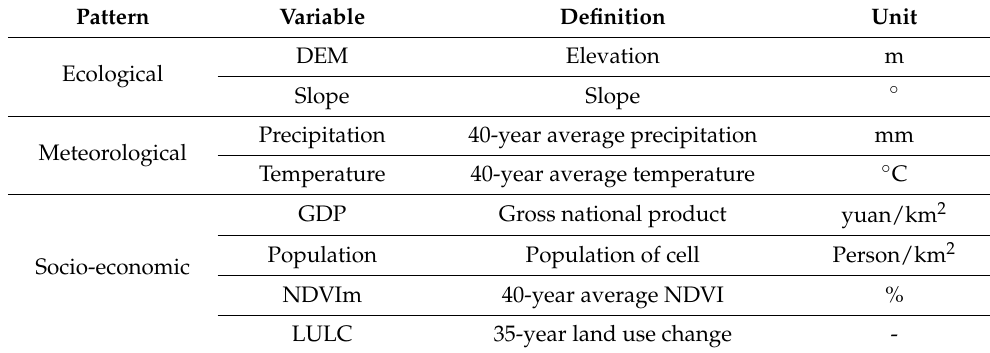
Table 2. Driving factors of ESs change. Pattern Variable Definition Unit